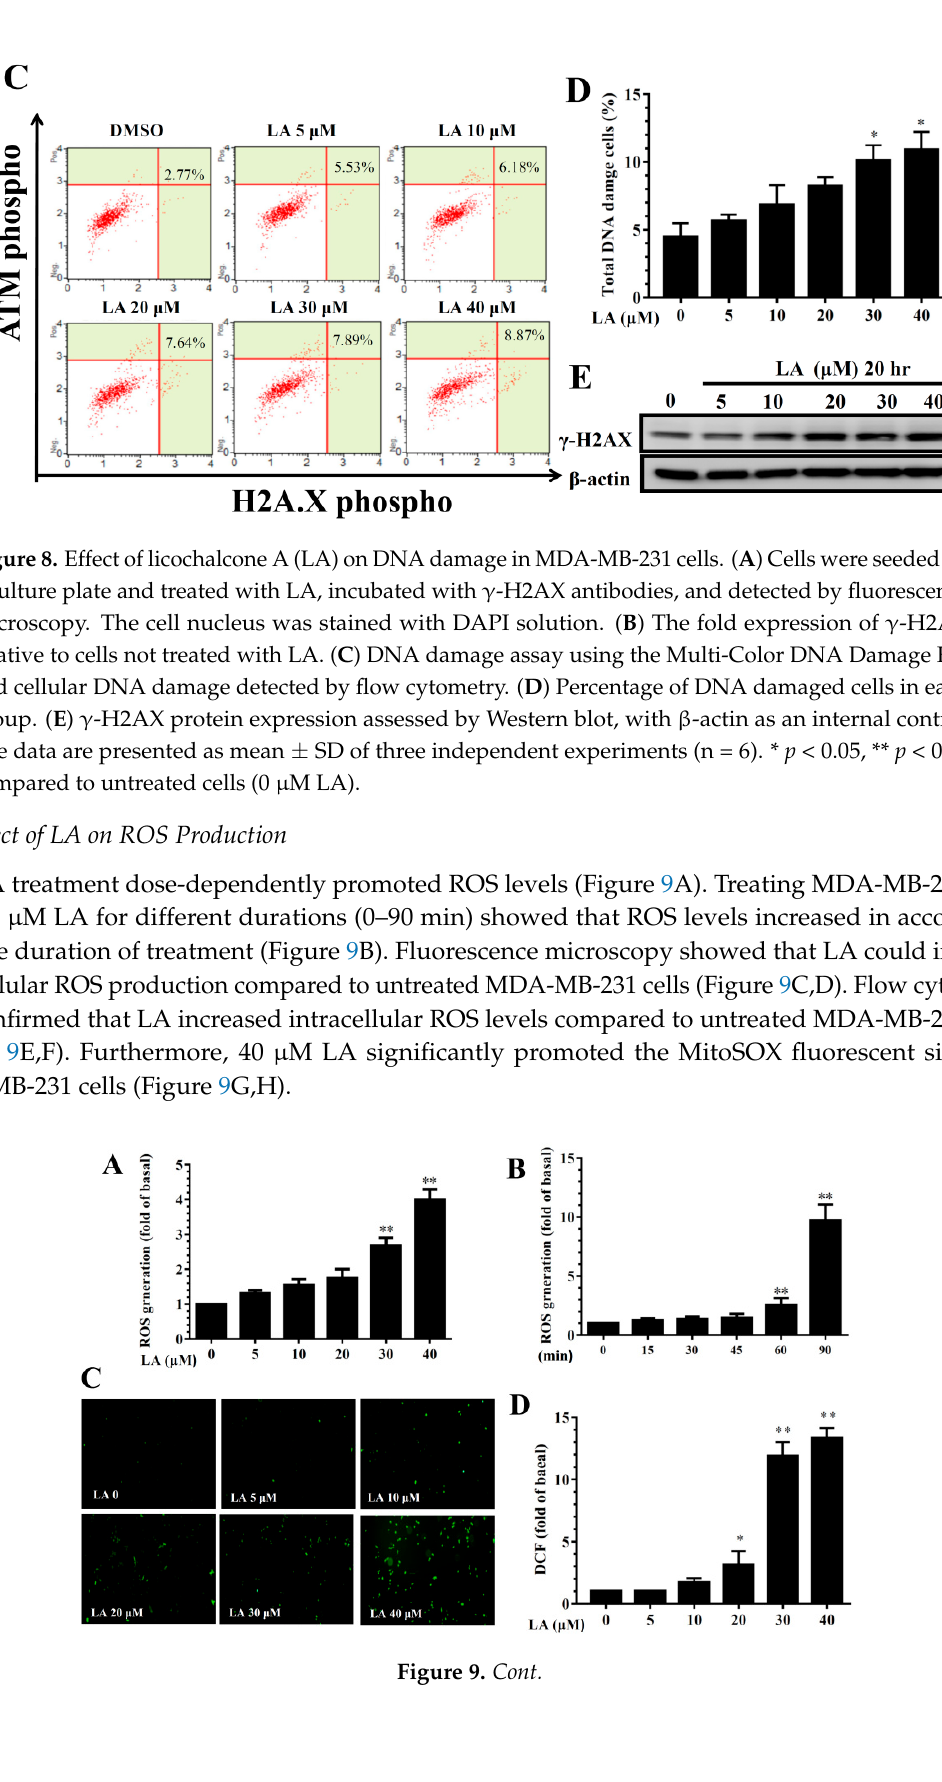
Figure 9. Effects of licochalcone A (LA) on reactive oxygen species (ROS) production in MDA-MB-231 cells. ( A ) ROS levels detected in MDA-MB-231 cells treated with 0-40 μ M LA. ( B ) ROS levels detected in MDA-MB-231 cells treated with 40 μ M LA for the indicated times. ( C ) Fluorescence microscope images of intracellular ROS. ( D ) Percentage of ROS detected in cells with the indicated LA concentrations compared to untreated cells. ( E ) ROS measured using the Muse™ Oxidative Stress Kit and detected by flow cytometry. ( F ) Quantification of ROS as the fold expression relative to untreated cells (0 μ M LA). ( G ) Mitochondrial ROS detected by MitoSOX, with MitoTracker Green FM as the mitochondrial control. Mitochondrial ROS were observed using a fluorescence microscope. ( H ) Quantification of ROS as the fold expression relative to untreated cells (0 μ M LA). The data are presented as mean ± SD of three independent experiments (n = 6). * p < 0.05, ** p < 0.01 compared to untreated cells (0 μ M LA). 3.10. LA Regulated Autophagy in MDA-MB-231 Cells LA significantly increased LC3B expression compared to untreated MDA-MB-231 cells (Figure 10A,B). In addition, MDA-MB-231 cells treated with LA expressed increased Beclin 1, ATG5, and LC3 II protein levels, but decreased P62 protein levels compared to untreated MDA-MB-231 cells in a concentration-dependent manner (Figure 10C).